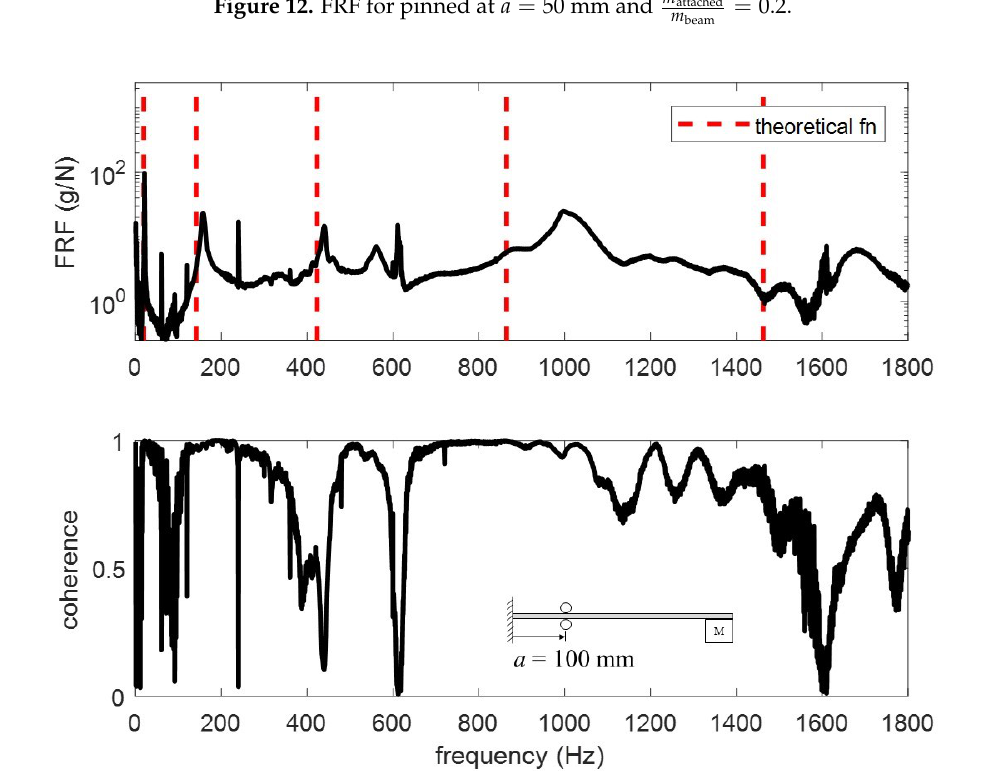
Figure 12. FRF for pinned at a = 50 mm and m attached